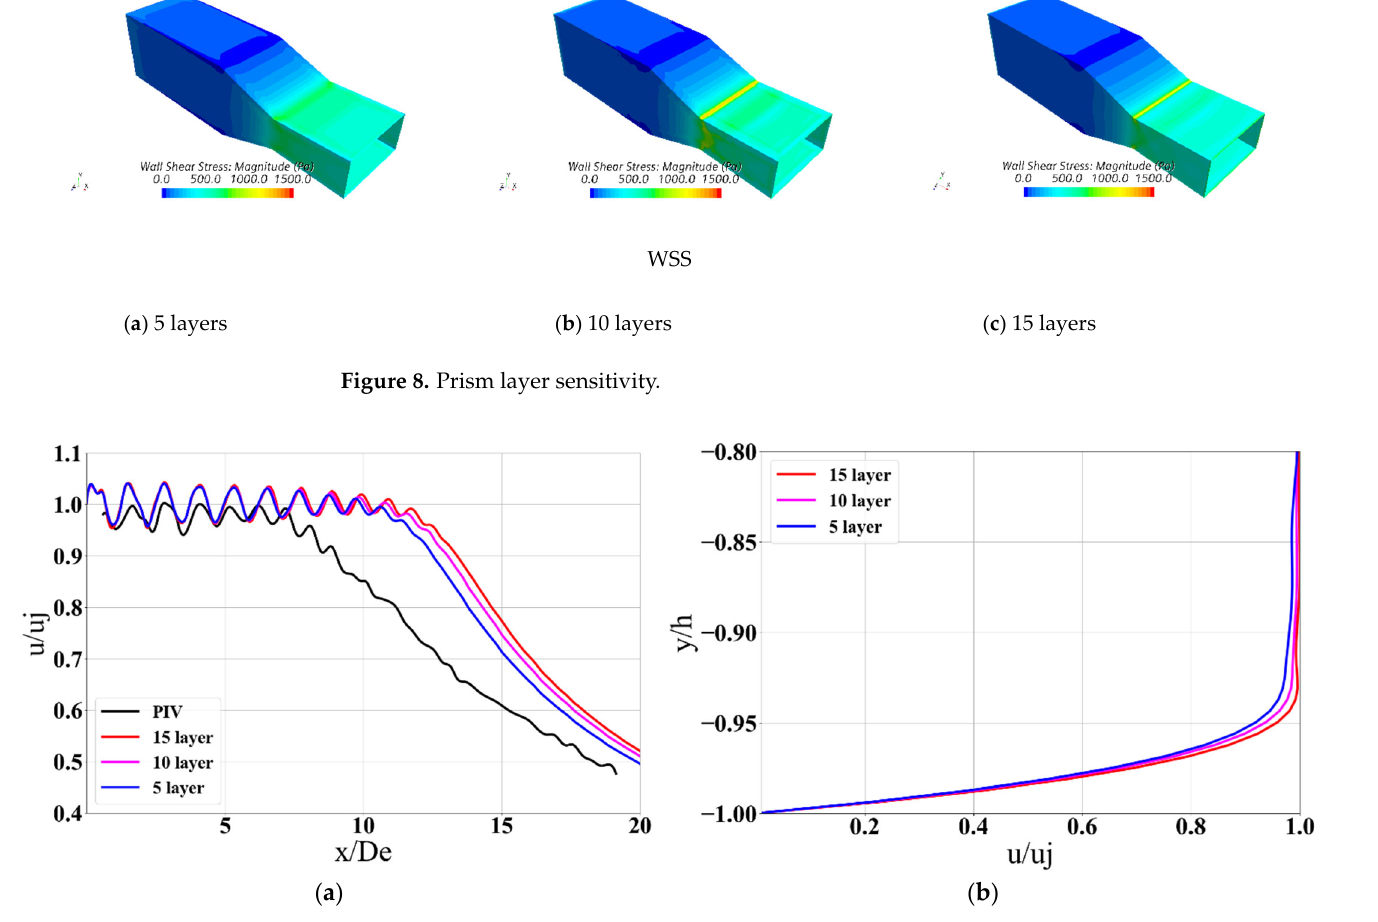
Figure 8. Prism layer sensitivity.